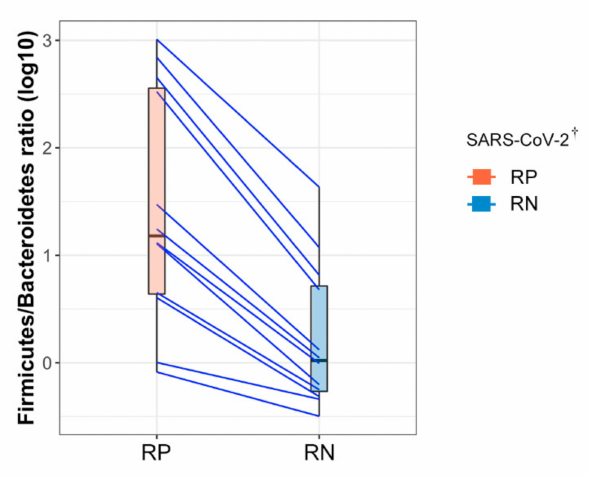
Figure 4. Comparison of Firmicutes to Bacteroidetes ratio in paired samples diagnosed with COVID- 19. Each point on the left and right sides of the slope graph corresponds to the samples collected in the infected state (respiratory positive (RP)-SARS-CoV-2) and in the recovered state (respiratory negative (RN)-SARS-CoV-2), respectively. Paired samples from the same subject are connected with a blue line showing the change in the ratio. † SARS-CoV-2 RNA from the respiratory tract. RP, respiratory positive SARS-CoV-2; RN, respiratory negative